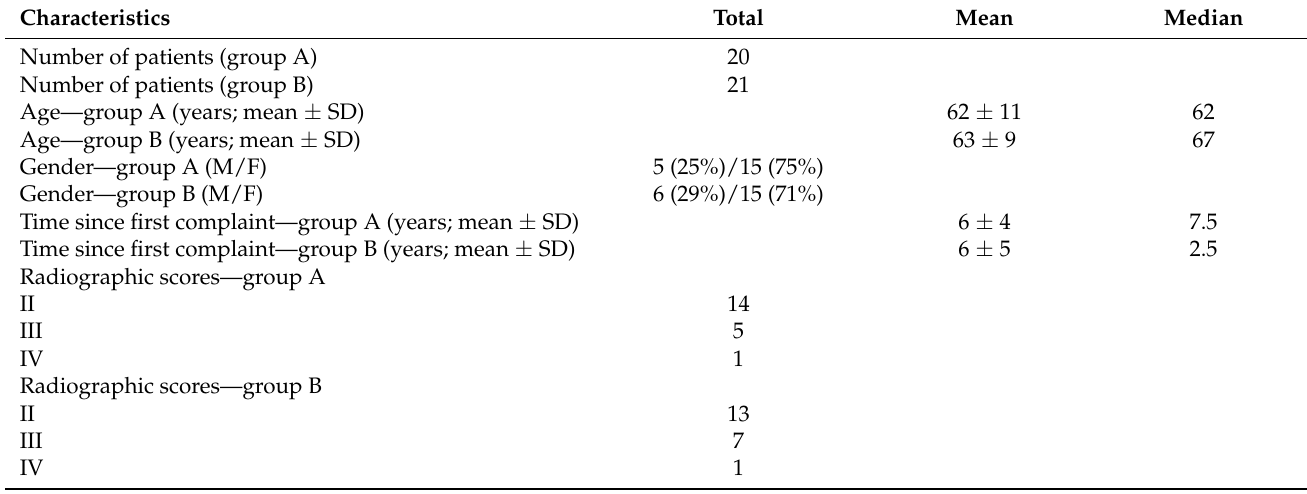
Figure 1. Consort 2010 flow diagram. Table 1. Clinical, demographic, and radiological characteristics presented by patients at the beginning of the